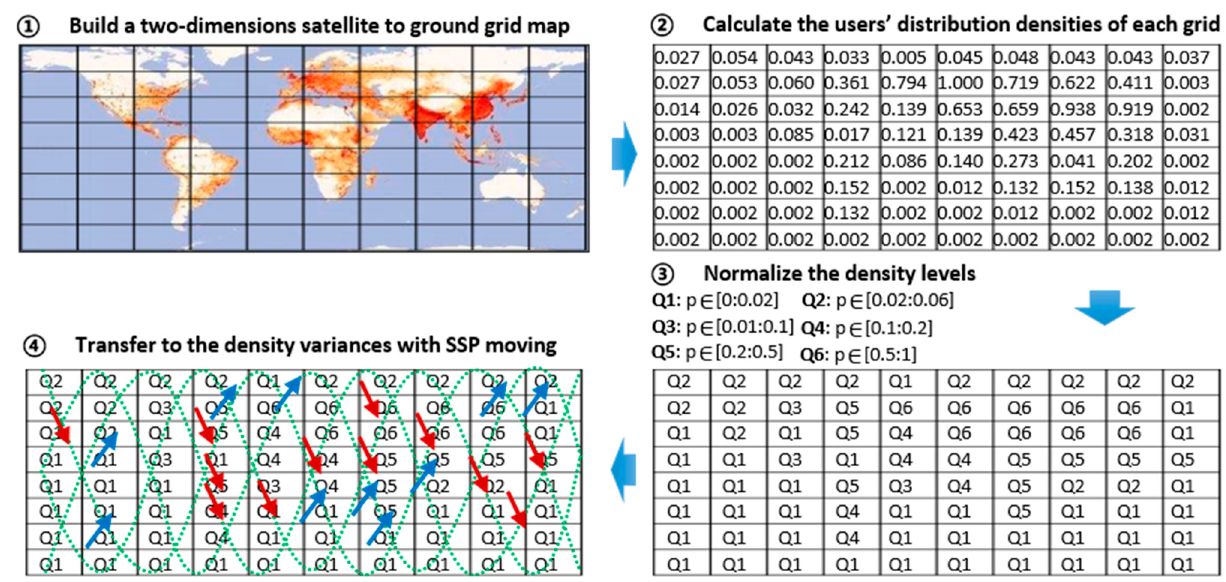
Figure 3. The user model and distribution of S-IoT-N.